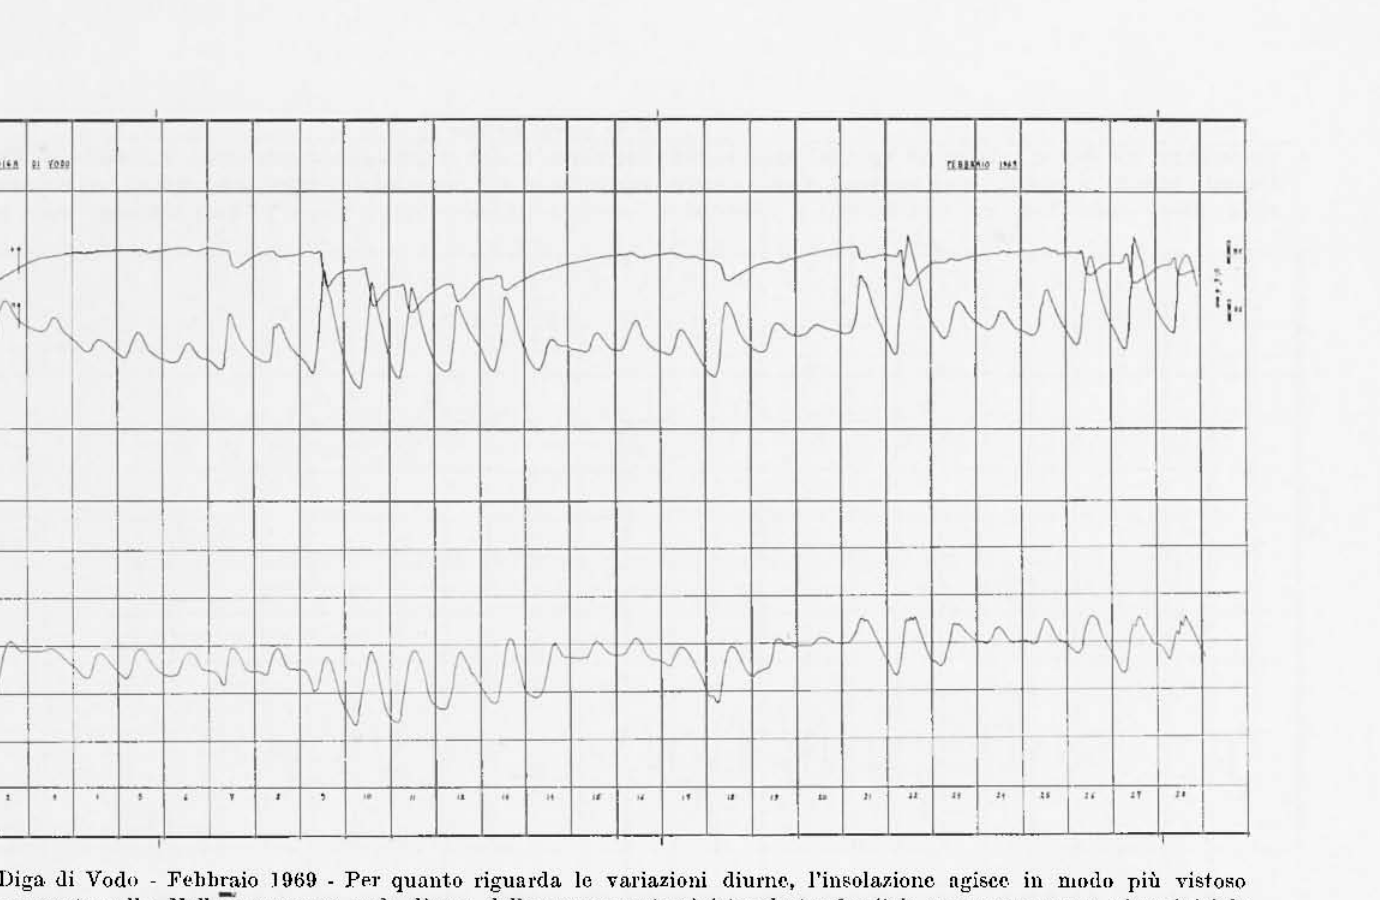
Fig. 4 - Diga. ili Vodo FelllJraio 1969 _ PP]" quanto riguarda le variazioni diurne, l'insola7.ionc agisce in DIodo più vistoso iu direzione monte-valle. )l'cllol lUr sca.rse onùe diurne della. componente sinistra-destra. fa gii\.la sua. comparsa UII picco iniziale a d!'~tra, che si unùri'l. aecentuuuùo Ilei me~i successivi. Le lente variazioni di temperattITa dell'aria si riflettono in a.na.loghe lente variazioni dI'ila verticale apparente; quelle della componente monte-valle SOIlO a monte I)eI' riscaldamento, quelle (h'lla eomponeute sinistra-destra. in corrispondenza, ~OIlO ora a destra ora a